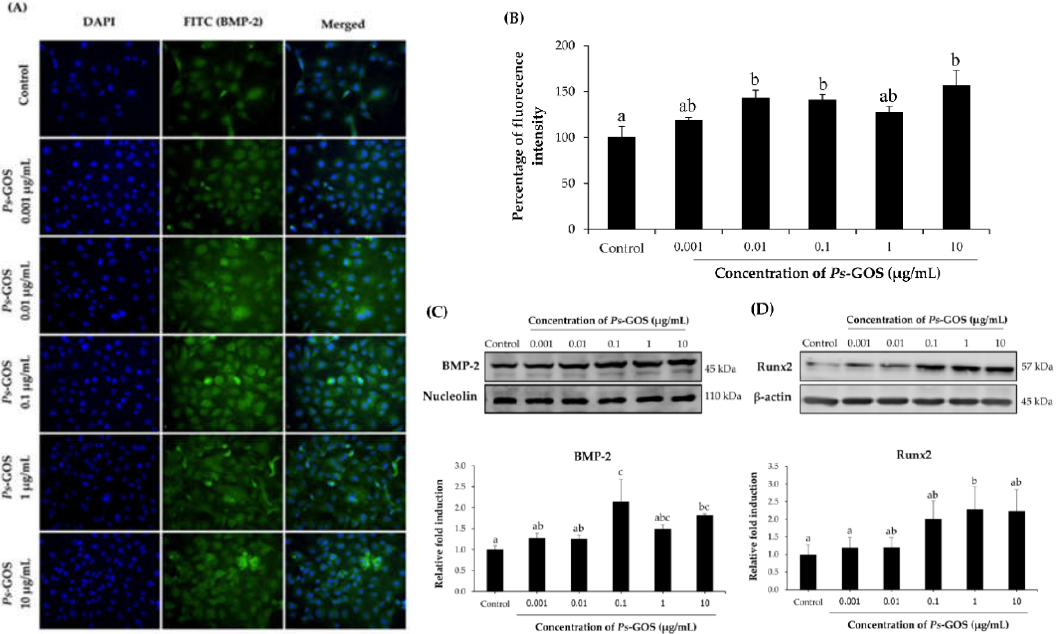
Figure 5. E ff ect of Ps -GOS on the bone morphogenetic protein (BMP) signaling pathway in osteoblast cells. Osteoblastic MC3T-E1 cells were treated with various concentrations of Ps -GOS for 2 days. ( A ) The image of BMP-2 expressing cells observed by immunofluorescence staining (original magnifications 20 × ). ( B ) Quantitation of immunofluorescence staining. ( C ) Protein level expression of BMP-2 was determined by Western blot analysis at day 2. ( D ) Protein level expression of Runx2 at day 10. The quantitation was calculated according to the referent bands of β -actin (C) and nucleolin (D). The data were obtained from four replicates as mean ± SEM. The data in columns with di ff erent letters in each group were significantly di ff erent at p < 0.05.